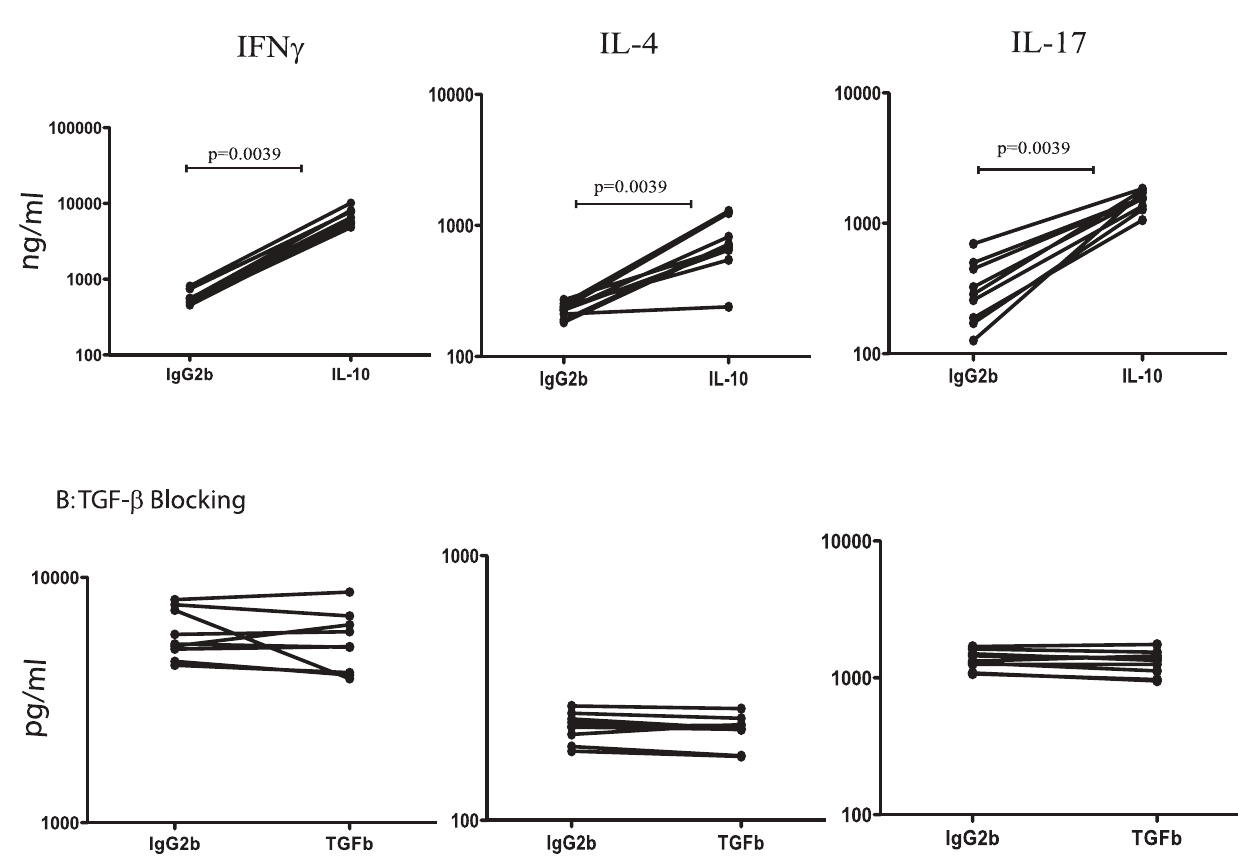
Figure 6. Neutralization of IL-10 but not TGF b significantly enhances cytokine production in PTB. Whole blood from PTB individuals was stimulated with PPD (10 m g/ml) in the presence of anti-IL-10 Ab or anti-TGF b Ab or isotype controls for 72 h and the levels of IFN c , IL-4 and IL-17A were measured by ELISA. Results are shown as line graphs with each line representing a single PTB individual (n=9). Results are shown as net cytokine production over media control. P values were calculated using the Wilcoxon signed rank test.